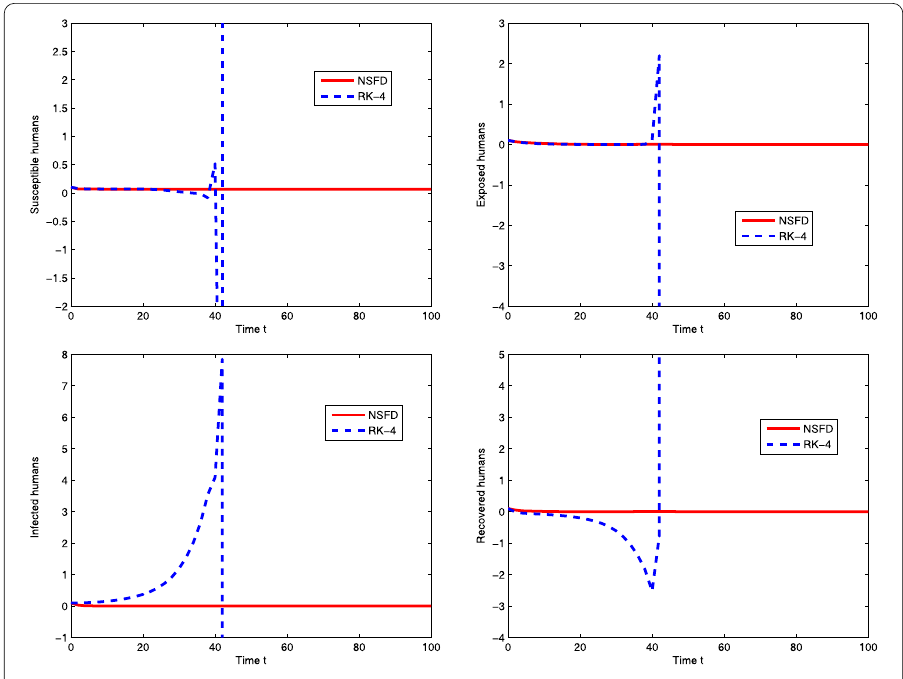
Figure 6 Comparison of solutions obtained by NSFD and RK4 numerical schemes for F 0 with an initial condition ( S (0), E (0), I (0), R (0)) = (0.1,0.1,0.1,0.1) and step size h = 2.0. The NSFD scheme converges to the true steady state of F 0 with R 0 = 0.2167 < 1, whereas the RK4 scheme is seen to be divergent